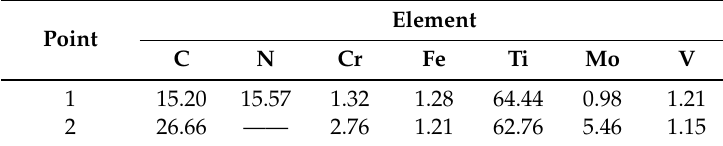
Table 4. EDS-analyzed results of compound containing titanium (mass